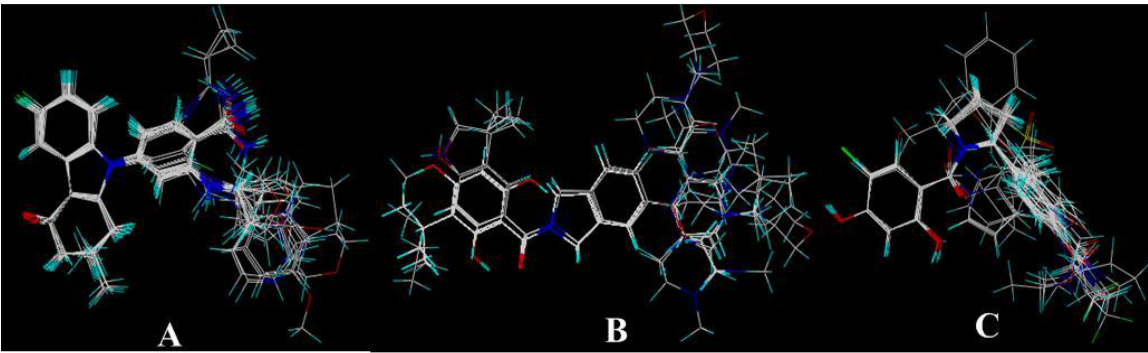
Figure 2. Ligand-based alignment. ( A ) Compound 17 was used as a template for alignment; ( B ) Compound 24 was used as a template for alignment; ( C ) Compound 19 was employed as a template for alignment. C is colored in white; H is colored in cyan; O is colored in red; N is colored in blue; S is colored in